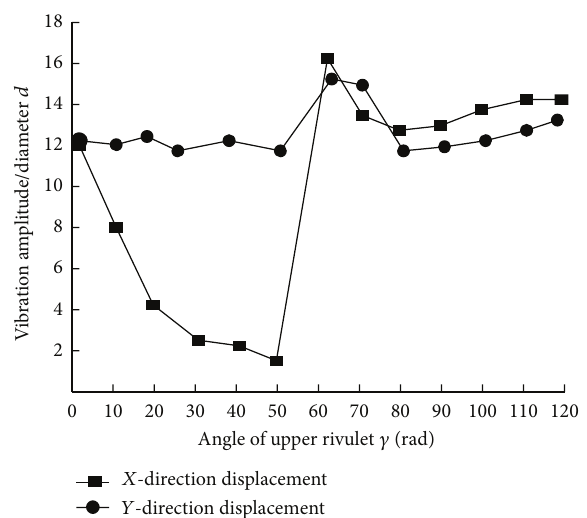
Figure 10: Effects of the angle 𝛾 of the upper rivulet on vibration amplitude of the leeward